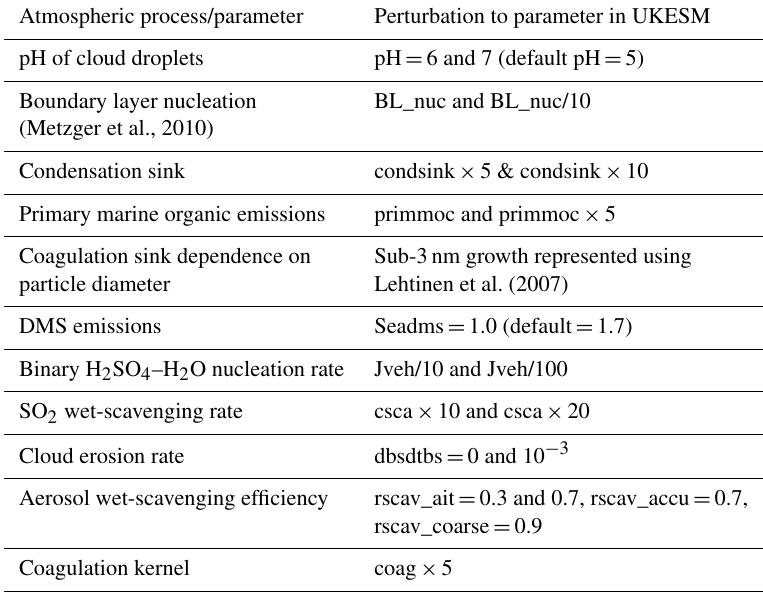
Table 1. Overview of the atmospheric processes that we have chosen for one-at-a-time sensitivity tests and the magnitude of the perturba- tion/scaling